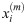
Behavior of simplified networks.(A) Network 1. (B) Network 2. In (A) and (B), each number represents the chemical index, with orange-circle and green-square nodes representing diffusible and non-diffusible chemicals, respectively. The difference between networks 1 and 2 lies only in the diffusibility of X5. The dashed arrows denote the diffusive fluxes of chemicals, and the thick arrows indicate catalytic reactions. The chemical at the arrowtail is transformed to the chemical at the arrowhead, catalyzed by the chemical labeled on the edge; e.g., the left arrow from X0 in (A) denotes the catalytic reaction X0 + αX1 → X3 + αX1. When the cells differentiate, type-1 (type-2) cells mainly produce the chemicals X1 and X3 (X2 and X4), and receive X4 (X3) from type-2 (type-1) cells, which are illustrated in the lower panel with color. (C) and (D) are examples of the behavior of network 1 for (C, Vmed, D) = (0.15, 100, 1). (C) Chemical concentrations xi(m) in N cells surviving at time t = 105 are plotted according to the color code shown in the sidebar, with the vertical axis as the cell index m and the horizontal axis as the chemical index i. The top band designates an “isolated” cell. (D) The time series of the number of cell divisions per cell for interacting (red) and isolated (blue) cells.